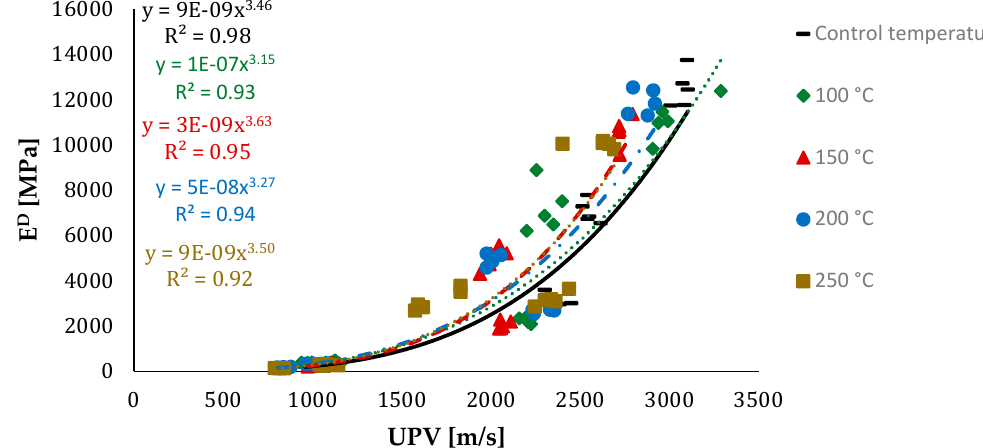
Figure 10. Relationship between ultrasound pulse velocity and Young’s modulus.